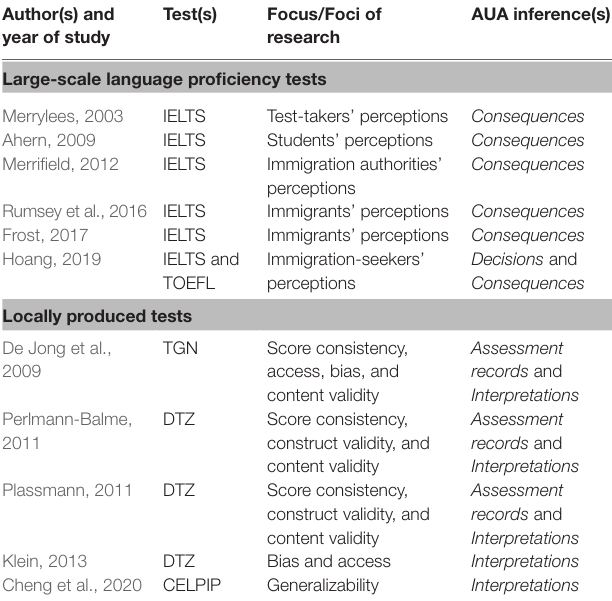
TABLE 1 | Empirical validation research on language assessment for